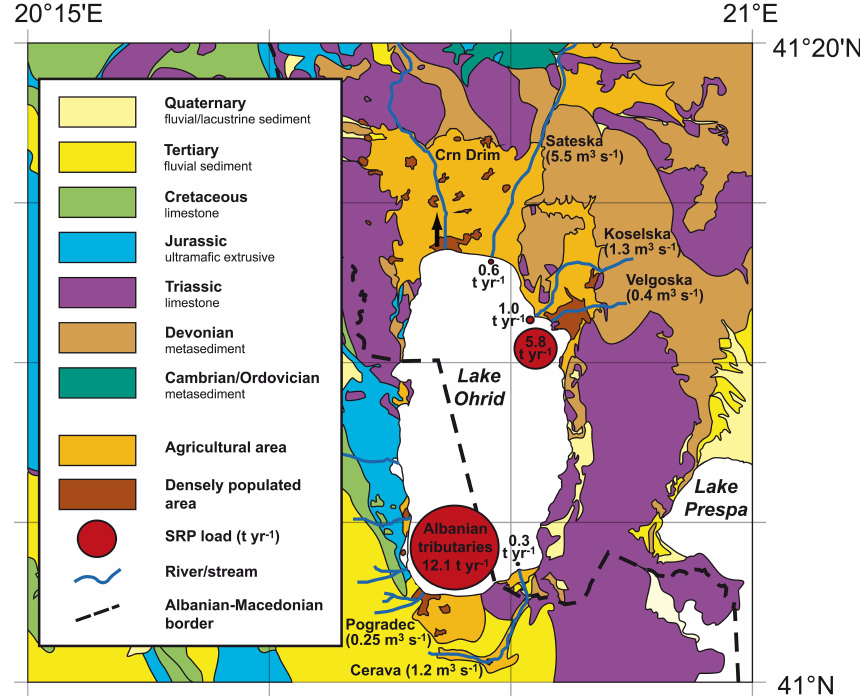
Fig. 1. Geological overview map of the Lake Ohrid vicinity on the base of accessible geological overview maps of Albania (e.g. Albanian geological survey, 1999) and Macedonia modified after Reicherter et al. (unpublished). Also shown are densely populated and agricultural ar- eas, major streams and inlets including discharge rates (annual mean) and loads of soluble reactive phosphorus (SRP) according to Matzinger et al.